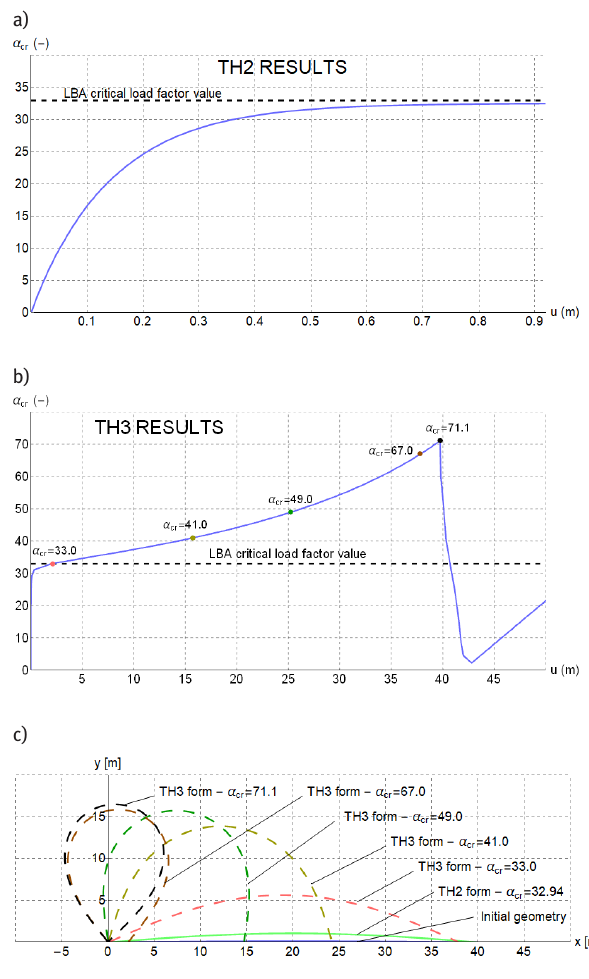
Figure 7: Midpoint equilibrium paths for TH2 (a) and TH3 (b) analyses and corresponding displacements (c) of 40-m-long column with a 1/300 elevation (equivalent imperfection e